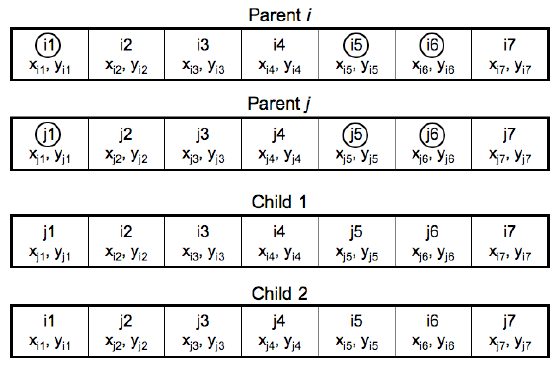
Fig. 3. An Example of Crossover The crossover operator is demonstrated in Fig.